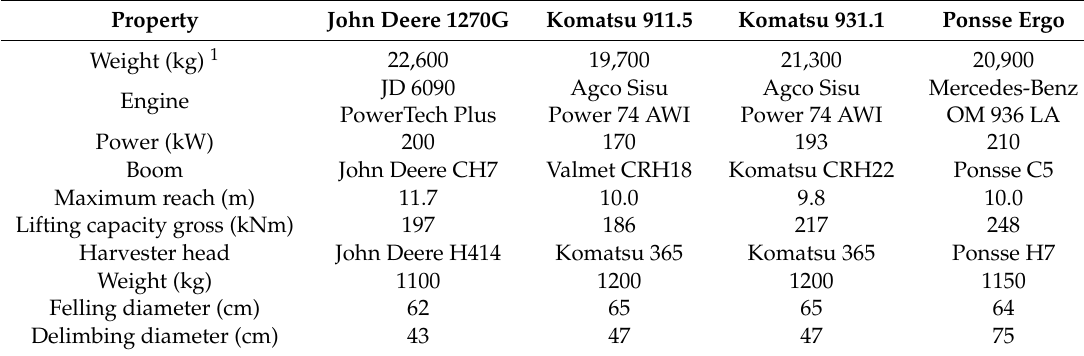
Table 1. Main technical specifications of the study